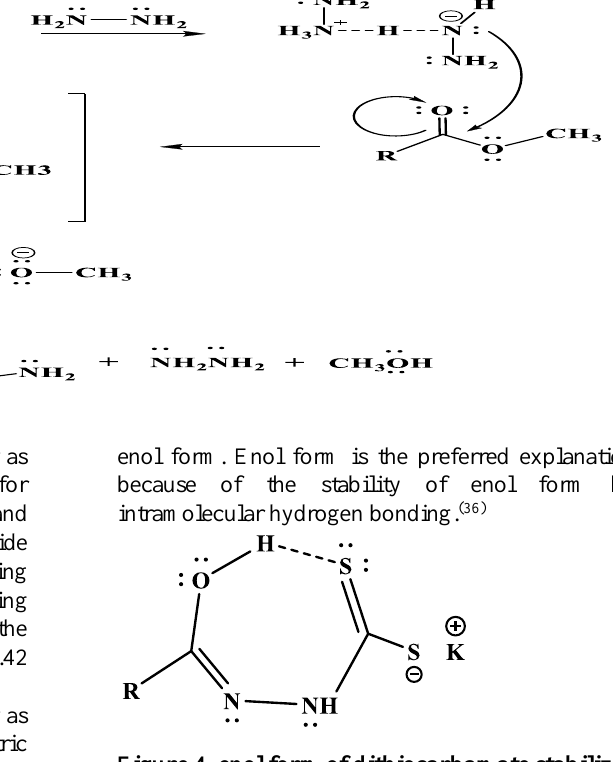
Figure 4. enol form of dithiocarbamate stabilized by intramolecular hydrogen bonding. (36)